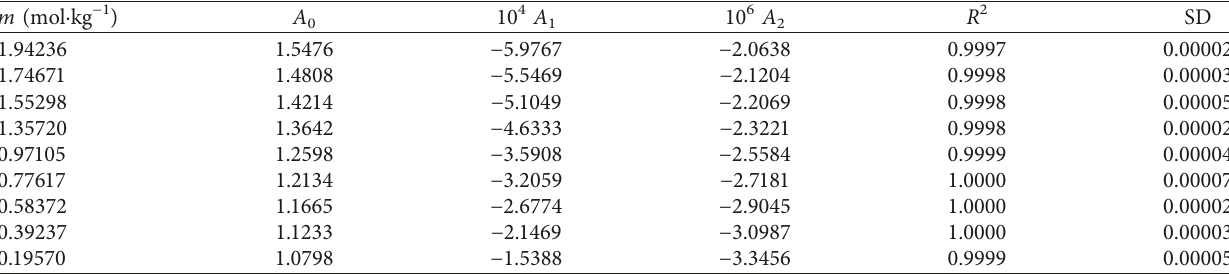
Table 4: The empirical constants ( A i ) and standard deviations (SD) of NaAsO 2 aqueous solution at different temperatures and ρ at constant molality and pressure.